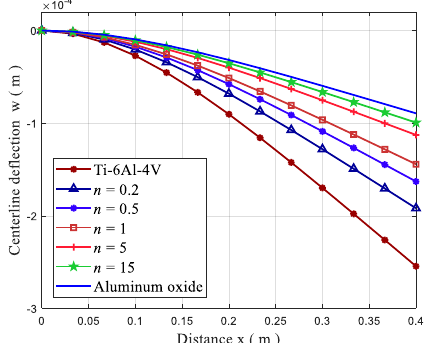
Figure 6. Deflection of a cantilevered PFGP with different gradient index n under the action of a uniformly distributed load.